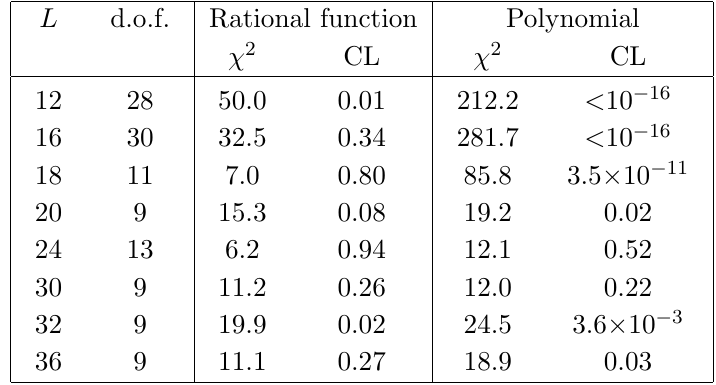
Table 25 . Quality of c = 0 : 3 renormalized coupling interpolations and columns as in table